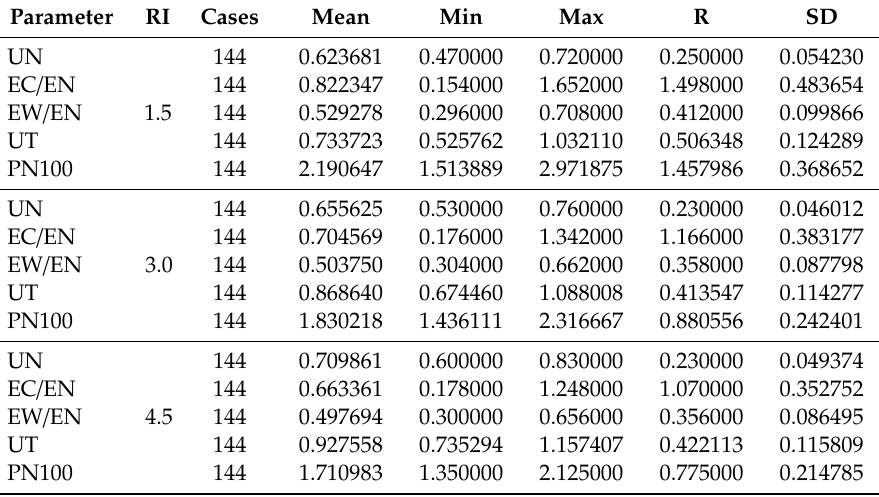
Table 3. Variation of lighting parameters for each room index